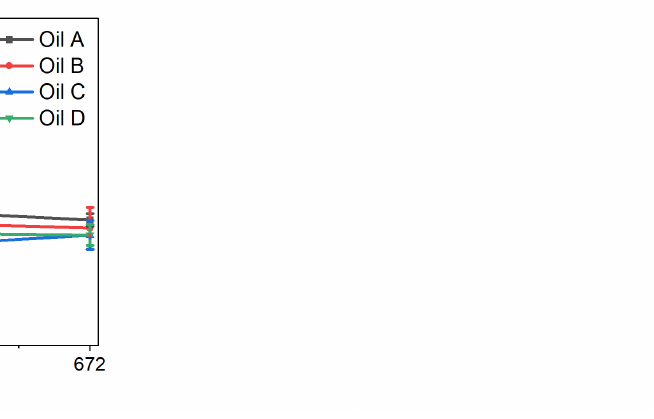
Figure 1. Changes in volume of PEEK, PA66, and PTFE after immersion in oils A, B, C and D.